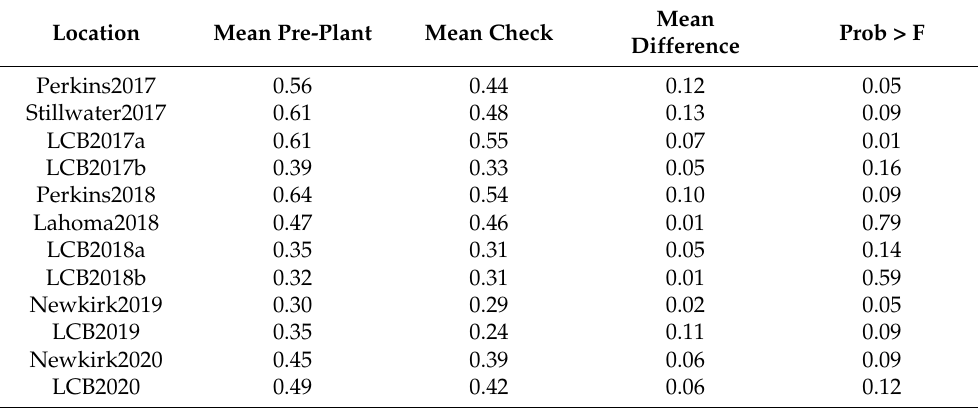
Table 4. Documented normalized difference vegetation index (NDVI) from the pre-plant (treatment 1) and the non-fertilized check (treatment 2) at visual deficiency in all site–years. Fertilizer applications and NDVI collection were initiated when the pre-plant treatment within at least one block was visually determined to be greener or had more biomass than the non-fertilized check. Mean Prob > Location Mean Pre-Plant Mean Check